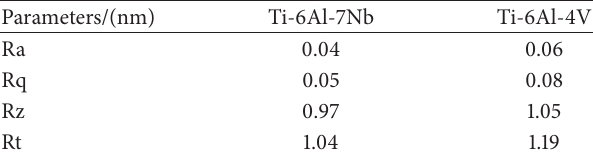
Table 3: Roughness parameters of Ti alloy after